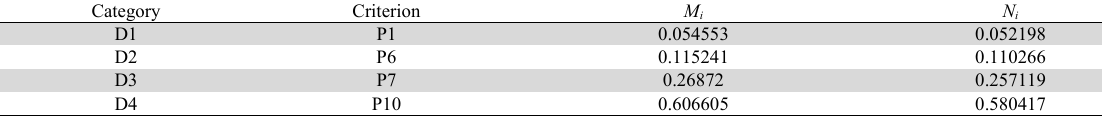
Centre of area method results and final criterion weights